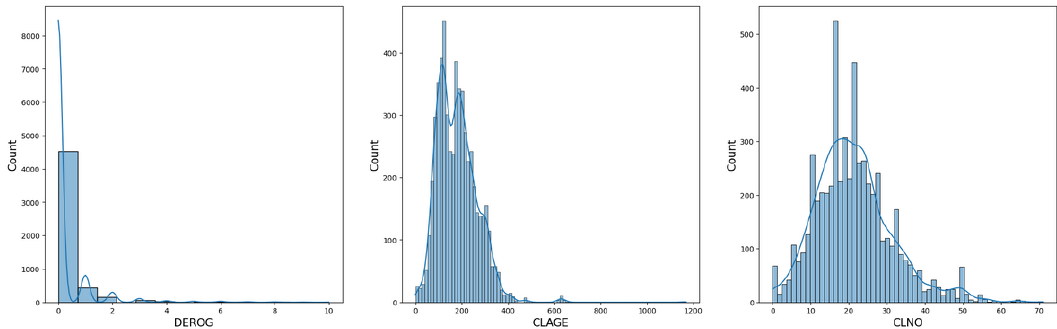
Figure 1. Feature distribution using histograms.